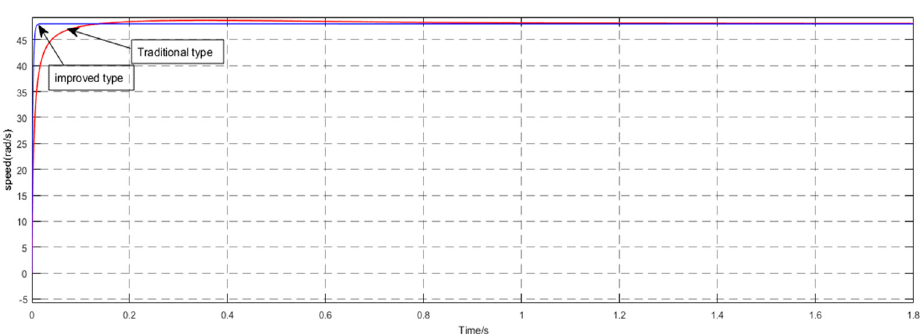
Figure 16. Comparison of the response of improved and traditional exponential approaching law.